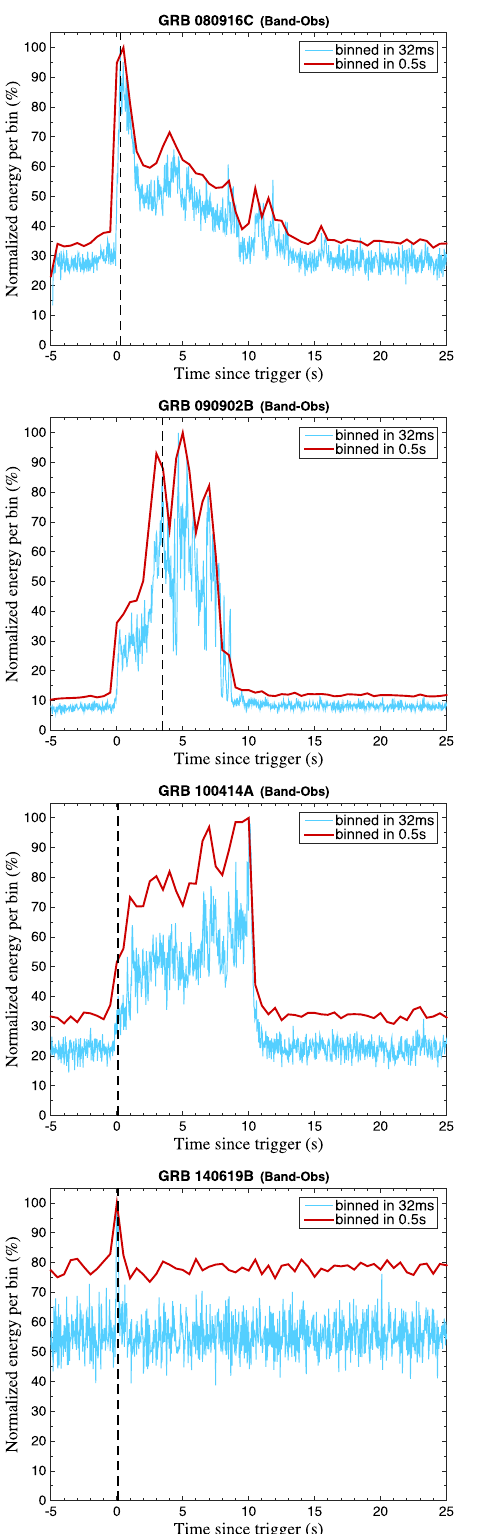
energy received in Band-Obs per bin divided by the maximum energy received per bin of the corresponding energy curve. The vertical dashed lines (black) refer to the first main peaks we choose for each